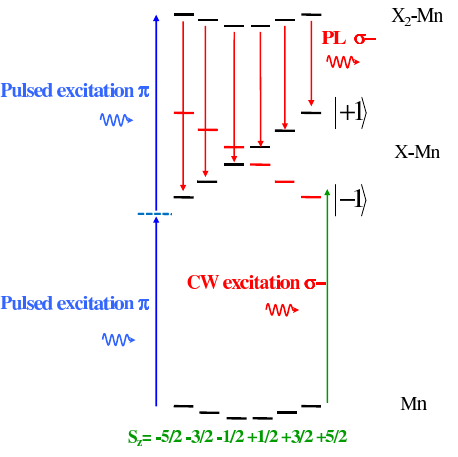
Figure 7: Scheme of the optical transitions and their polarizations in a quantum dot containing an individual magnetic atom and 0 (Mn), 1 (X-Mn), or 2 (X 2 -Mn) excitons. The exciton states are split by the exchange interaction with the Mn spin whereas in the ground (Mn) and biexciton (X 2 -Mn) states the energy levels results from the fine and hyperfine structure of the Mn spin. A direct resonant excitation of the biexciton is performed by a pulsed two-photon absorption through an intermediate virtual state whereas X-Mn states are resonantly excited by a tunable CW laser.